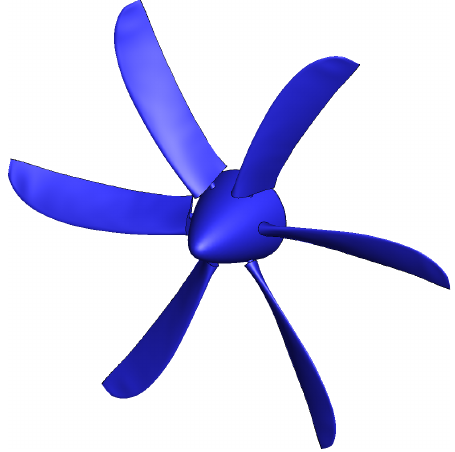
Figure 2. Dowty six-blade R391 propeller with 20-deg blade angle is shown. This propeller has a diameter of a diameter of 162 inches (4.12